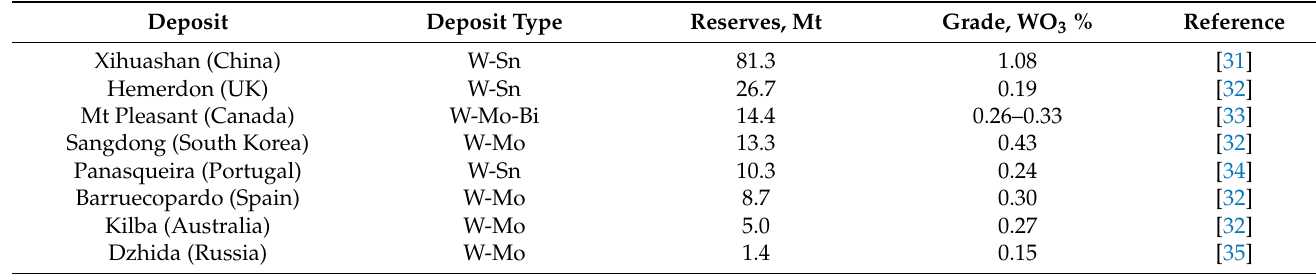
Table 2. Prominent reserves of tungsten deposits around the